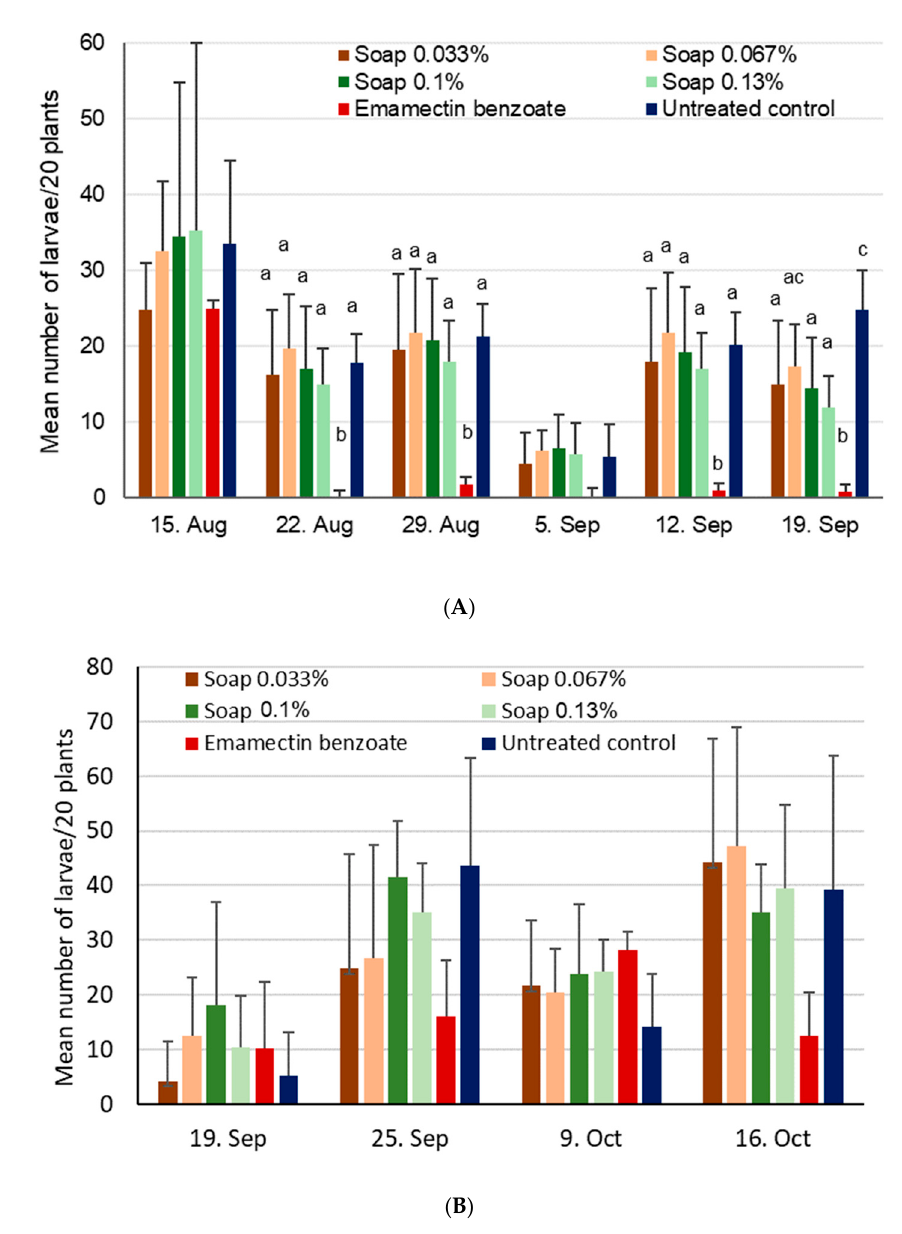
Figure 10. Mean number of FAW larvae + SD found on 20 maize plants after application of alata samina, a local soap, during vegetative growing stages conducted in the 2018 season. For a given date, treatment bars sharing the same letters are not significantly different from each other. ( A ) Site 1 near Wa, Upper West, Ghana, where treatments were applied on 16 August, 30 August, and 13 September. ( B ) Site 2 near Accra, Ghana, where treatments were applied on 20 September and 10 October. Crop damage was not significantly different at site 1 at first ( χ 25,18 = 5.3, p = 0.39), but this changed during the second assessment date ( χ 25,18 = 56.1, p < 0.001) due to low numbers for the positive control